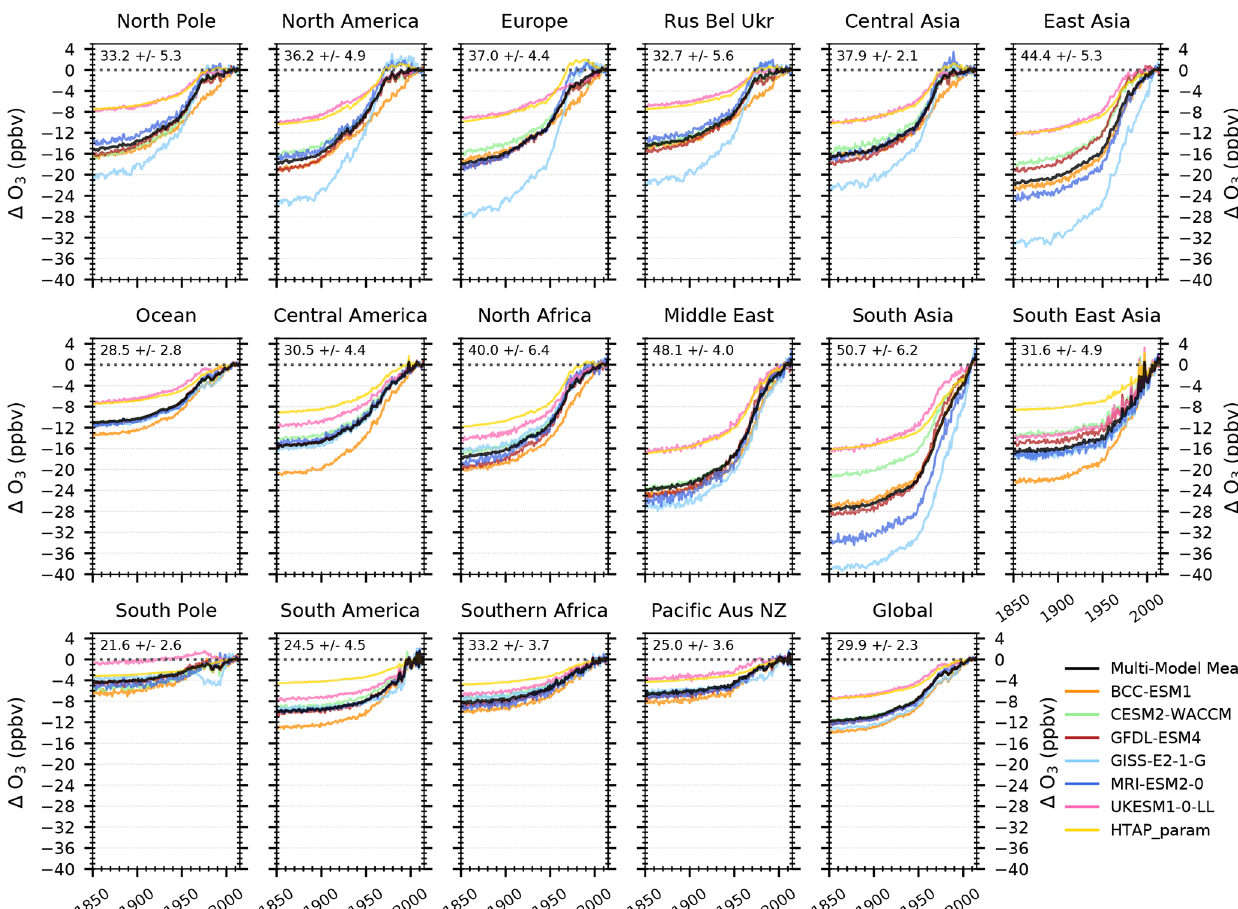
Figure 9. Changes in the regional and global annual mean surface O 3 concentrations, relative to a 2005–2014 mean value, across six CMIP6 models and the HTAP_param. The multi-model annual mean 2005–2014 surface O 3 concentrations ( ± 1SD) are shown in the top left of each panel. Regions are defined in Fig.